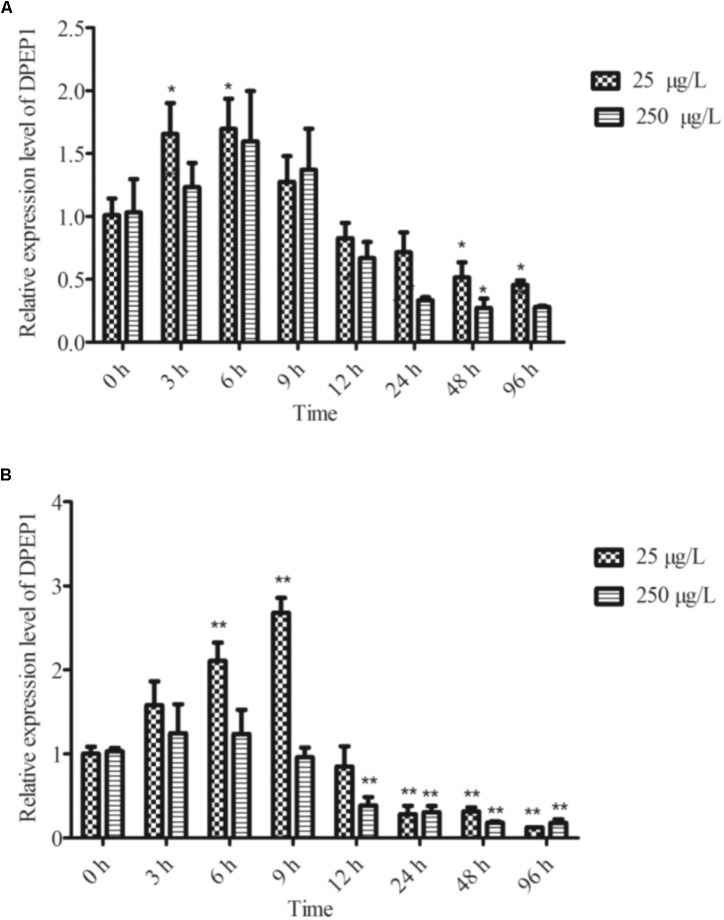
DPEP1 mRNA expression after Cd stress. (A) Temporal expression analysis of DPEP1 in gill tissue. (B) Temporal expression analysis of DPEP1 in blood. Asterisks indicate significant difference: ∗p < 0.05 and ∗∗p < 0.01. Control: samples obtained in 0 h.